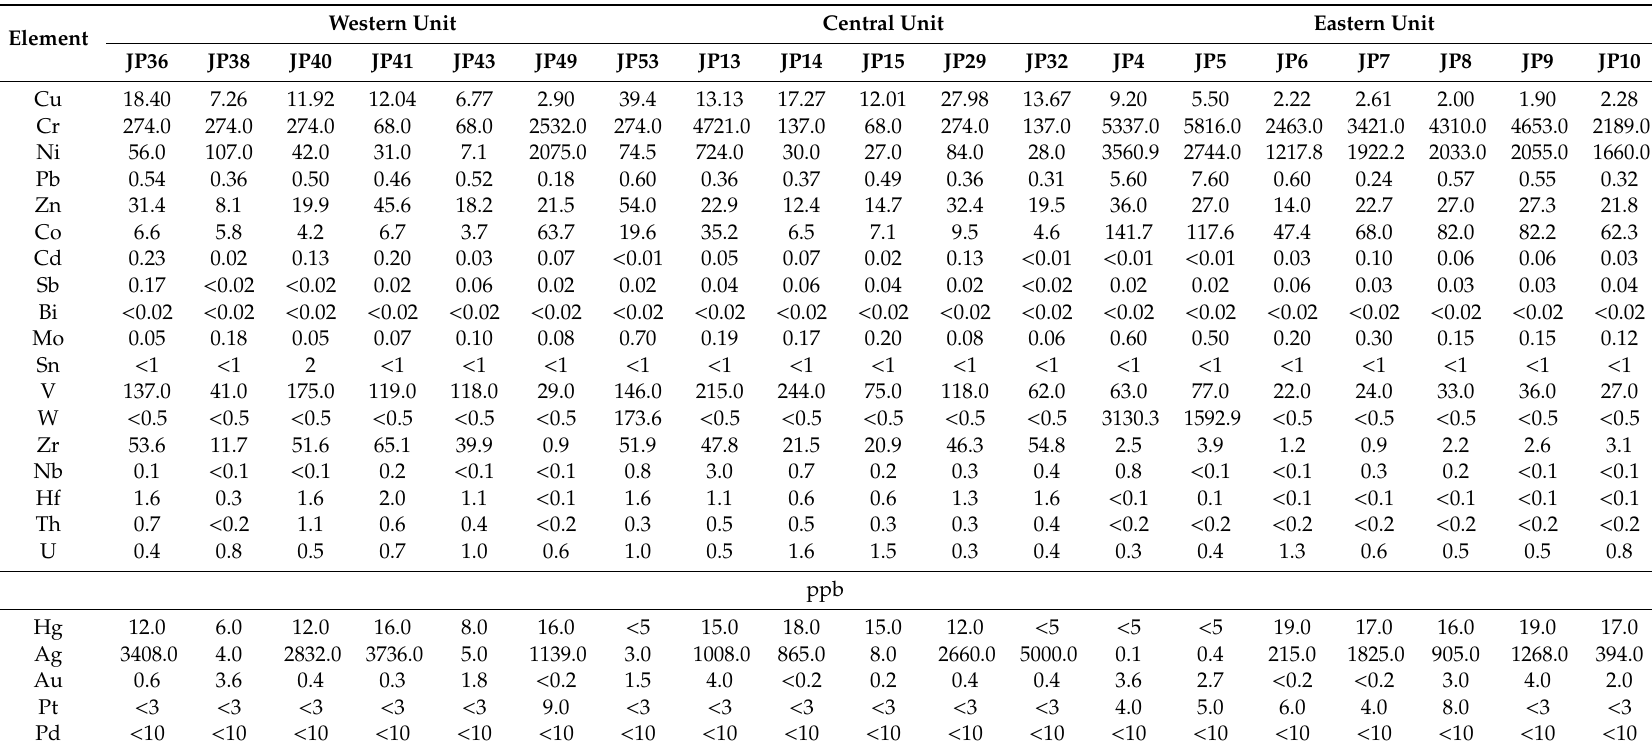
Table 2. The chemical composition of sediments (inductively coupled plasma mass spectrometry (ICP-MS) method, in